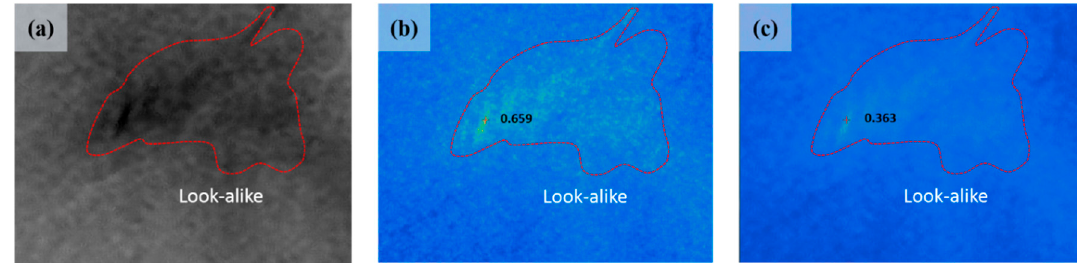
Figure 9. ( a ) Probability map of oil spill estimated following Process 1; ( b ) Probability map of oil spill estimated following Process 2; ( c ) Histogram of probability for the result of Process 1; ( d ) Histogram of probability for the result of Process Figure 10. ( a ) Enlarged image of look-alike area in intensity image; ( b ) Enlarged image of look-alike